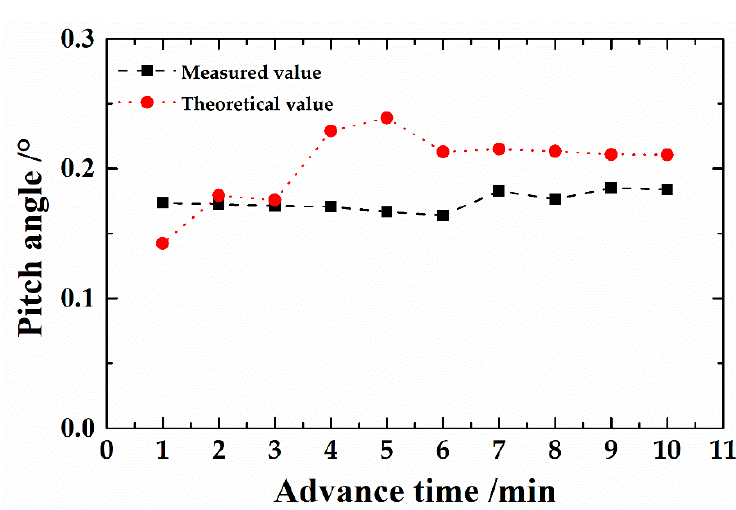
Figure 19. The change graph of M